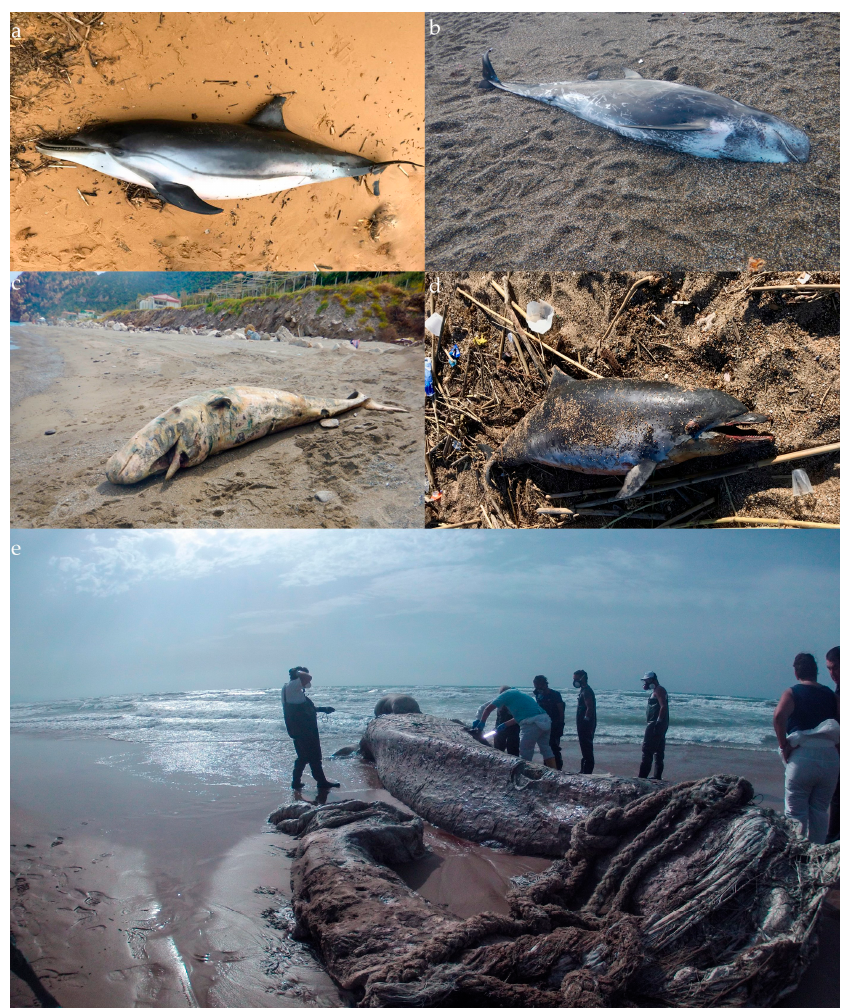
Figure 3. Some stranding events on the Sicilian coast: ( a ) Stenella coeruleoalba, striped dolphin, stranded in October 2018 (Triscina, Trapani); ( b ) Physeter macrocephalus , sperm whale, stranded in May 2019 (Capo Calavà, Gioiosa Marea, Messina); ( c ) Grampus griseus , Risso’s dolphin, stranded in February 2020 (Milazzo, Messina); ( d ) Tursiops truncates , common bottlenose dolphin, stranded in January 2021 (Palermo) (photos ©Andrea Calascibetta); ( e ) Necroscopy procedure performed by a IZS and IAS-CNR Researchers Team for a specimen of Balaenoptera physalus , fin whale, stranded in September 2014 (Triscina di Selinunte, Trapani) (Photo © Giuseppa Buscaino, Bioacoustics Lab of